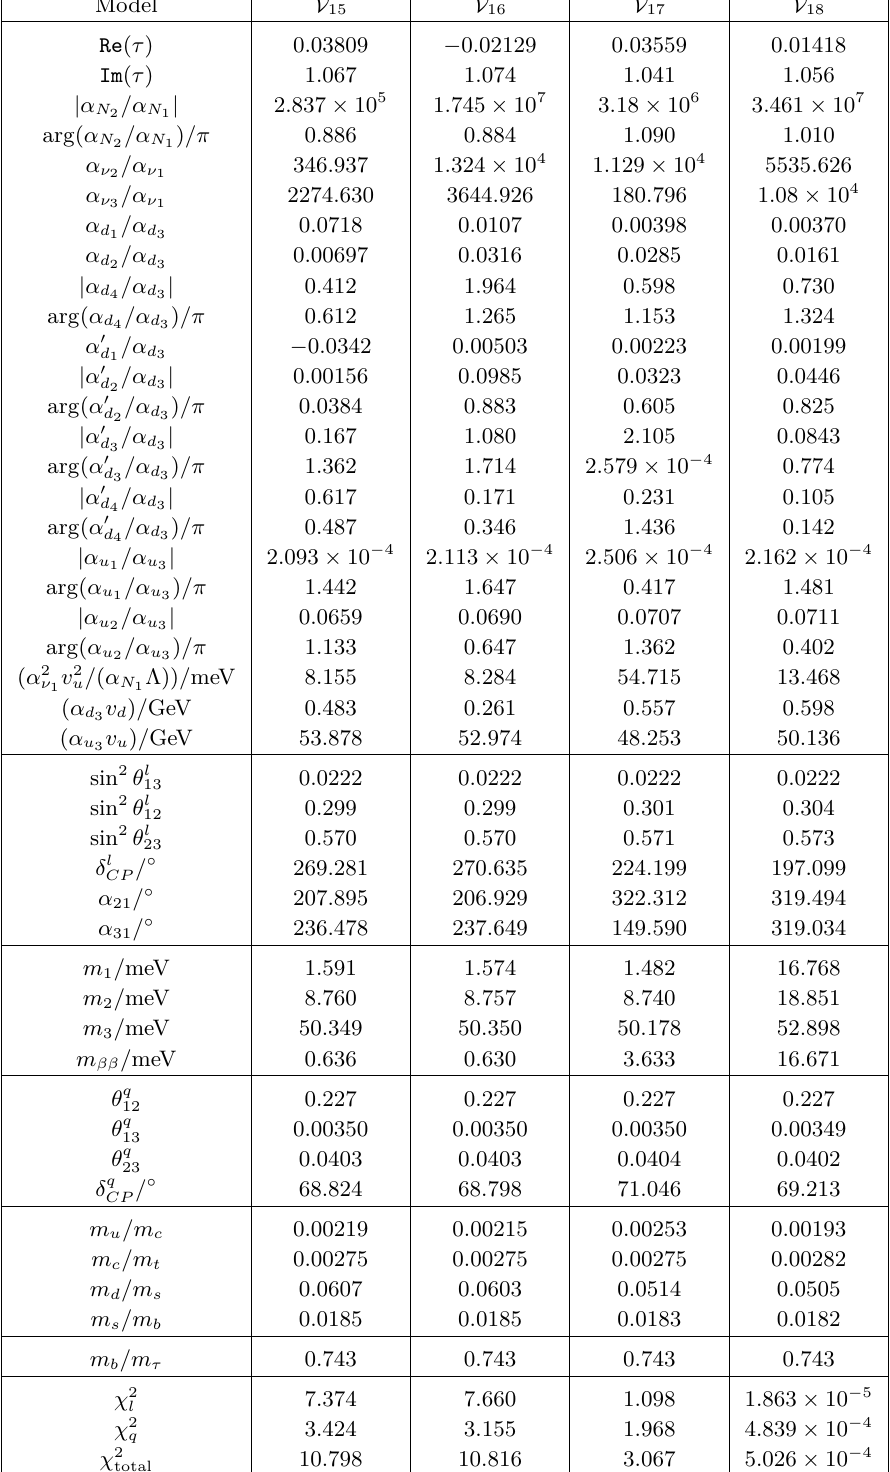
Table 12 . The best fit values of the free parameters and the corresponding predictions for lepton and quark mixing parameters and fermion masses for the phenomenologically viable models of Type-V (continuation of table